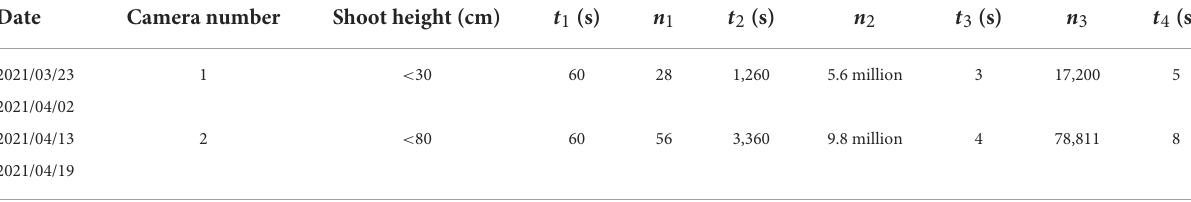
TABLE 3 Data acquisition and processing efficiency using MVS-Pheno V2 platform.